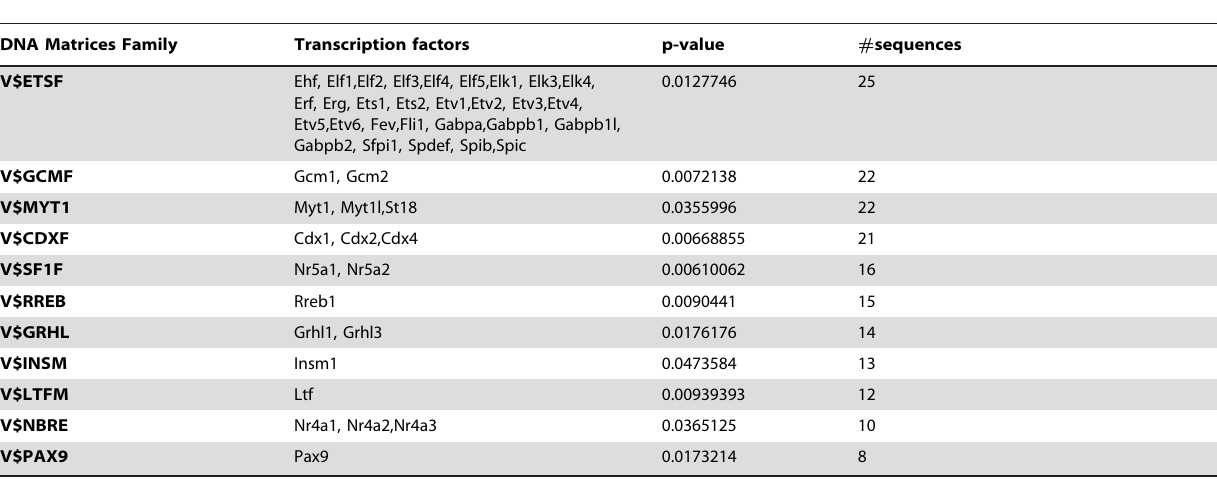
Table 7. List of Matrices Family overrepresented in the promoter sequences of the TCDD regulated genes in testes.